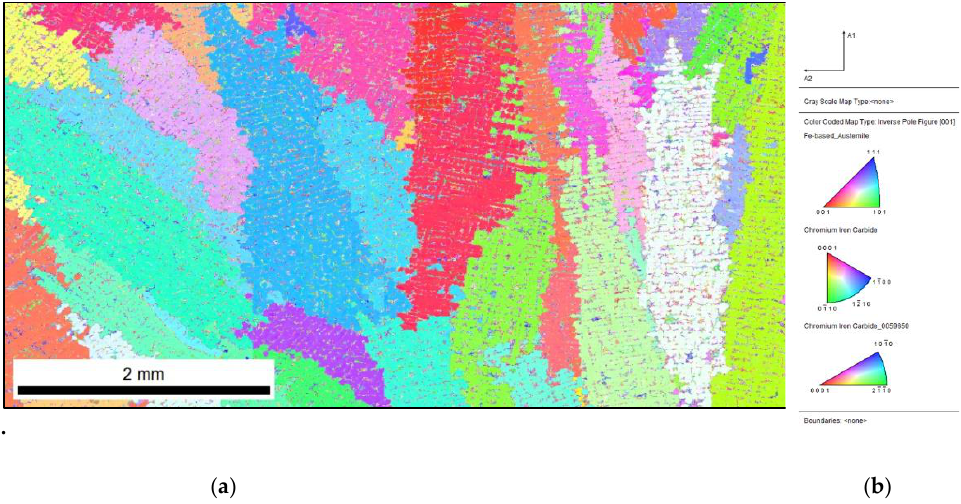
Figure 7. Inoculated sample with 0.17% Fe – Ti: ( a ) IPF map with marked primary grains; ( b ) refer- ence triangle.